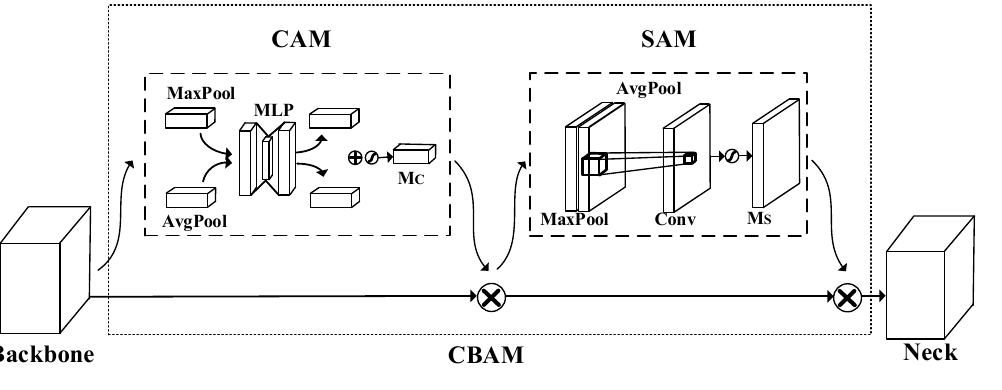
Figure 10. Structure of CBAM. MLP, multi − layer perceptron.